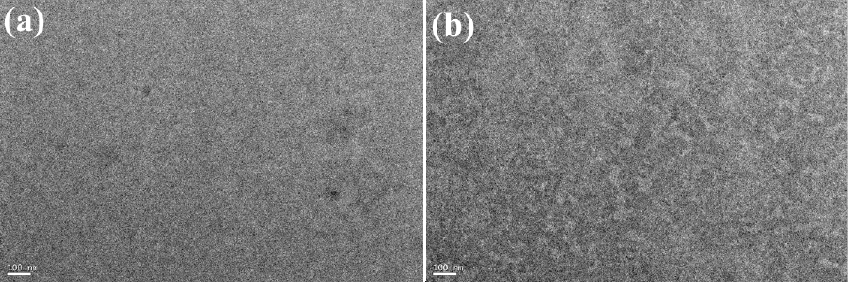
Figure 11. TEM bright field images of photoactive layers for PBDT-TVT-BT / PC 71 BM (1:1.5, 3% DIO, a ) and PBDT-TVT-FBT / PC 71 BM (1:1.5, 3% DIO, b ). The scale bar of TEM images is 100 nm.